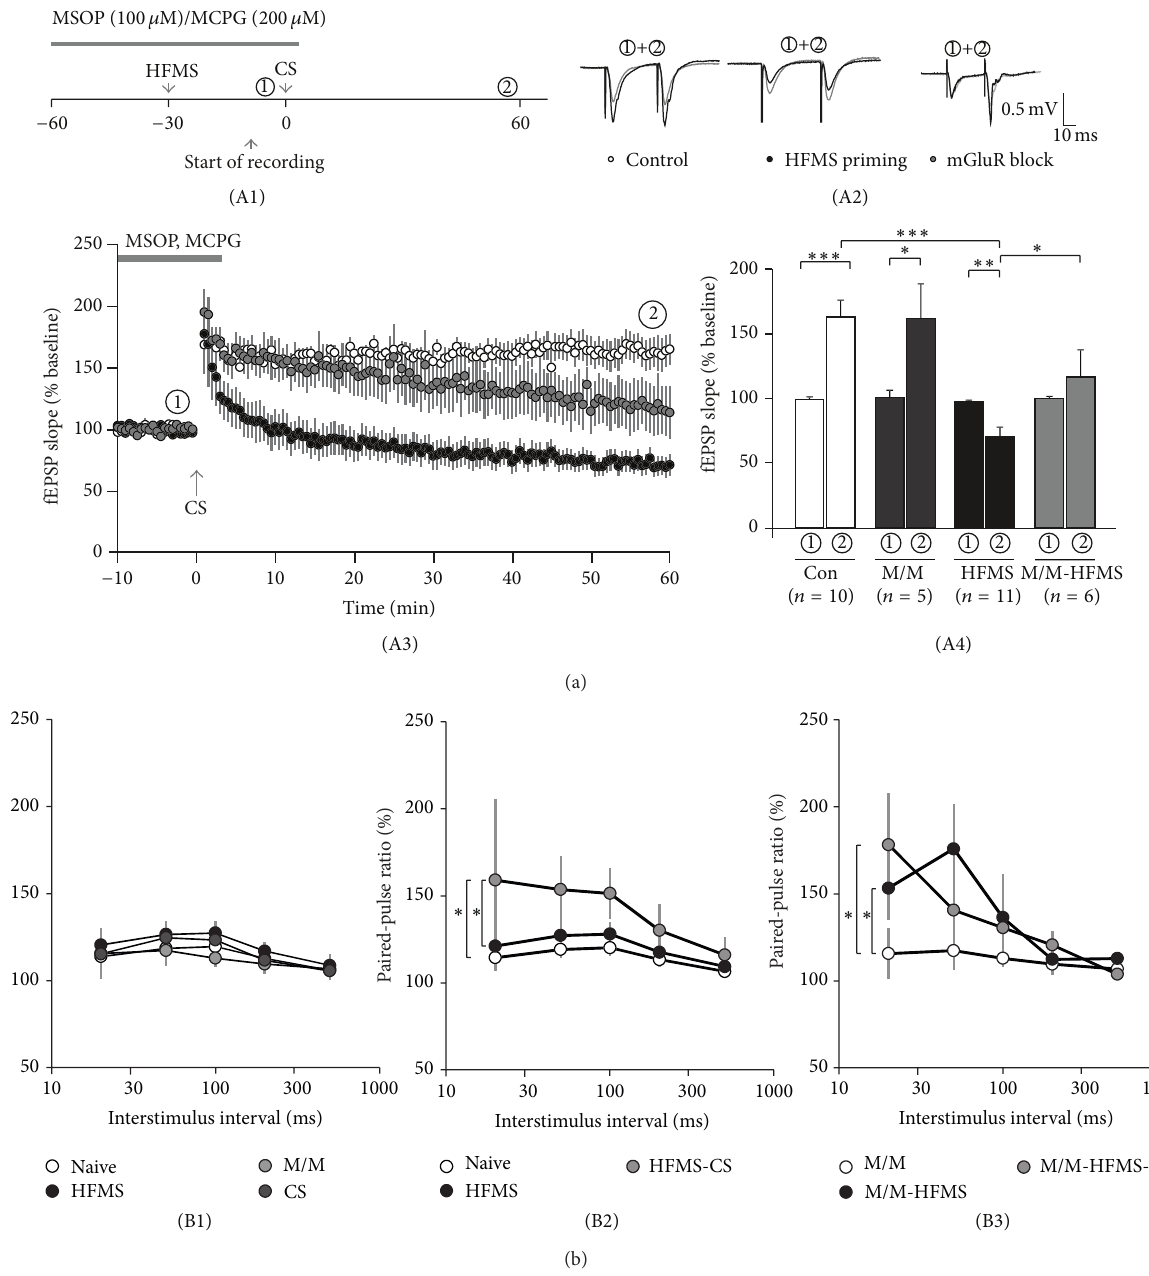
Figure 1: Electrical stimulation-induced LTP is lost after HFMS priming. (A1) Experimental paradigm showing the timepoints of high- frequency magnetic stimulation (HFMS) and conditioning stimulation (CS). Application of the mGluR blockers MSOP and MCPG is indicated by the gray bar. (A2) Sample traces of timepoints A and B in naive slices (control), in HFMS-primed slices, and under mGluR- blocking conditions. (A3) Time course of electrical stimulation-induced plasticity with (closed circles) or without (open circles) priming with high-frequency magnetic stimulation (HFMS). A subset of slices was bathed in MSOP and MCPG during HFMS and CS (gray circles). Baseline recording was started 20 min after priming stimulation using the following HFMS paradigm: 10 bursts (1s apart) of 20 pulses at 100Hz with 5 repetitions (10s apart) as previously published [8]. At 30min after HFMS (i.e., after 10min baseline recording), slices were electrically stimulated (conditioning stimulation, CS) using a paradigm composed of 10 trains of 20 pulses at 100Hz (1s apart) at time point 0 min (gray arrow). (A4) Percentage of mean fEPSP slopes calculated during 56–60 min after CS application. Significant LTP was induced by the CS paradigm in control slices without priming stimulation (open bar). In contrast, a significant LTD, but not LTP, was induced in slices with priming HFMS (closed bar). MSOP/MCPG application did not alter LTP in naive slices (M/M) but prevented CS-induced LTD in HFMS-primed slices (M/M-HFMS). (b) Paired-pulse plasticity in control experiments (B1), metaplasticity experiments in standard solution (B2), and metaplasticity experiments in mGluR-blocking conditions